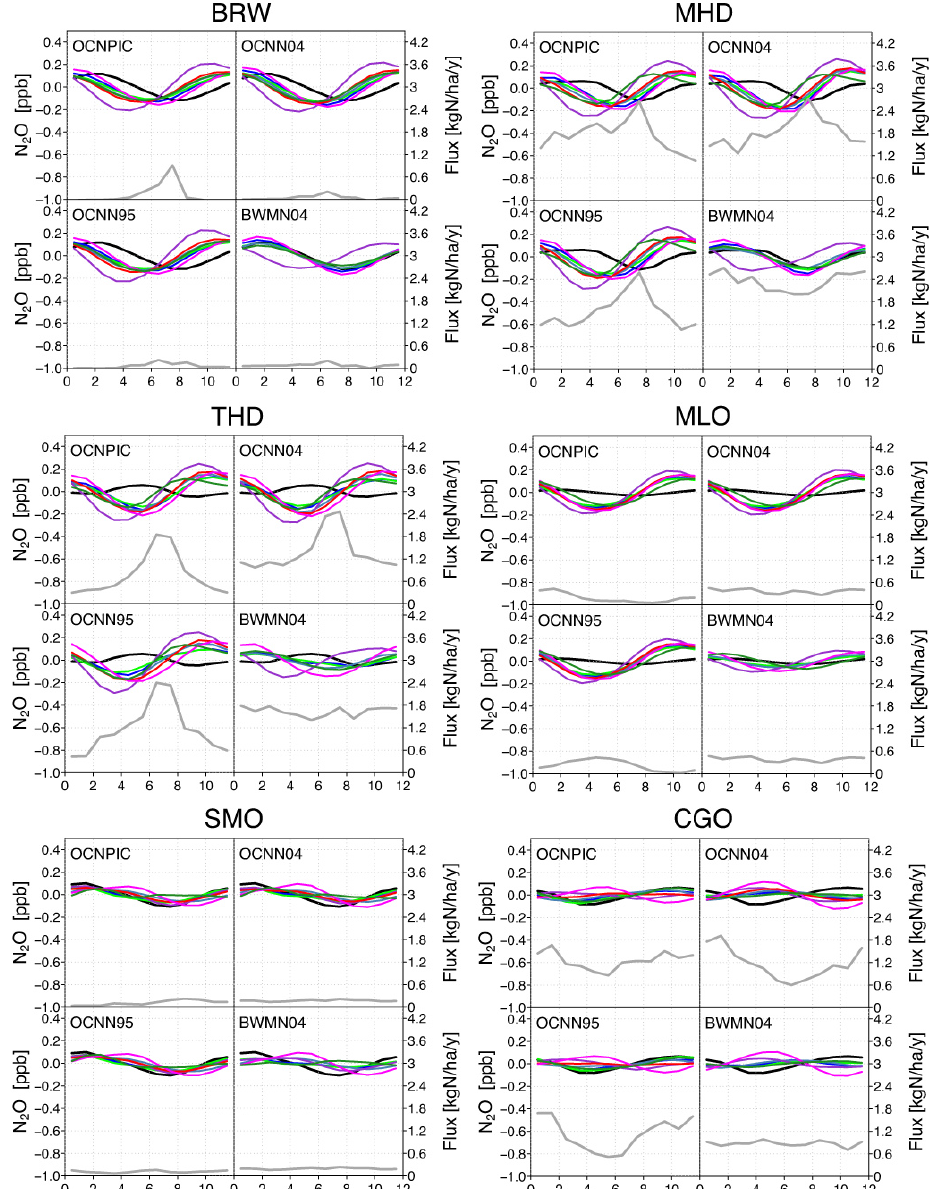
Fig. 10. Comparison of observed mean N 2 O seasonality (2006–2009) with that modelled using four different prior flux models. Each station is shown as a separate panel and within each panel the four subplots are for each of the flux models as indicated in the top-left corner (see Tables 2 and 3 for a description of the fluxes). N 2 O mixing ratio is on the left axis and N 2 O flux (grey line) is on the right axis. Legend: Mozart4, yellow; ACTMt42l32, blue; ACTMt42l67, green; TM5, grey-blue; TM3-NCEP, purple; TM3-ERA, red; LMDZ4, magenta; TOMCAT, dark green; observed, black.